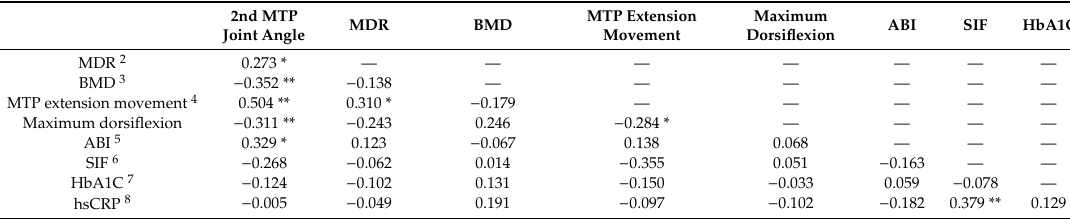
Table 3. Pearson correlation matrix for primary variables of interest. 1